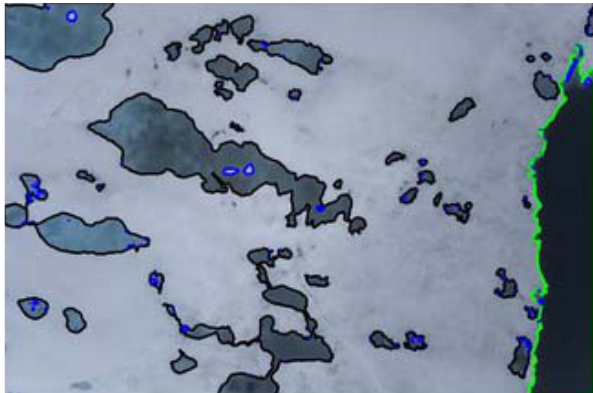
Figure 2. Example of the image segmentation procedure showing an image captured during flight 1 from an altitude of 35m. The dimensions of the scene are 60.5 by 40.5m. Black contours high- light the edges of melt ponds; the green contour outlines the open- water area; blue is for the smaller patches of sea ice within melt- pond/open-water objects. For this particular scene the melt-pond fraction f mp (relative to sea-ice area) and open-water fraction f ow are 16 and 8%,